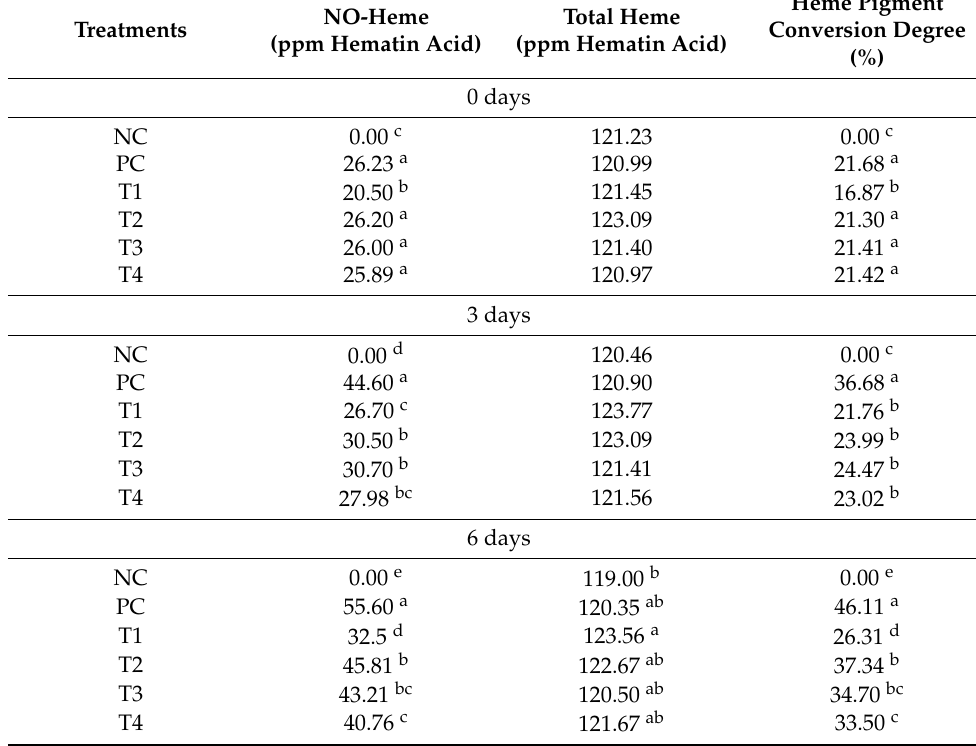
Table 5. Changes in NO-heme value, total heme value, and heme pigment conversion degree of minced pork depending on treatment and storage